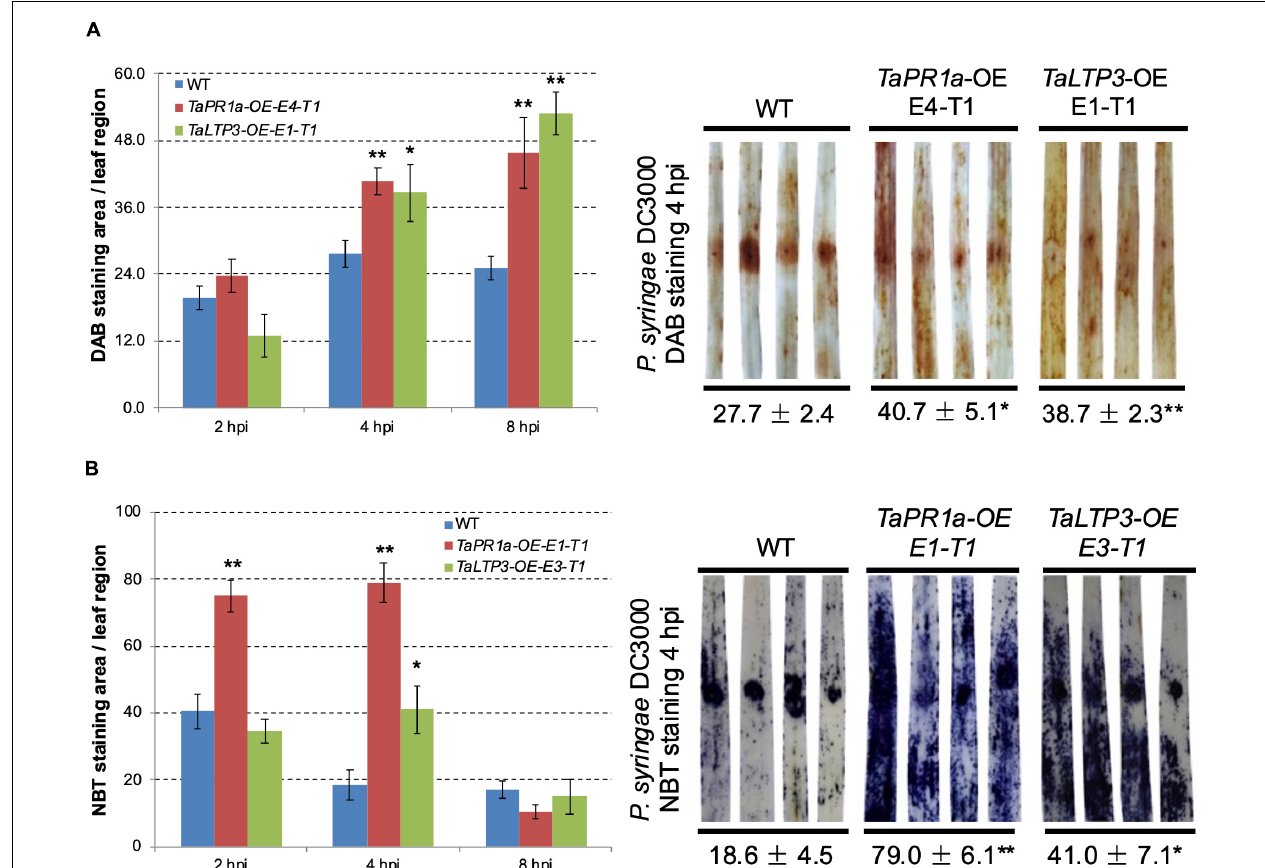
FIGURE 6 | Transgenic wheat lines TaPR1a-OE and TaLTP3-OE showed higher accumulation of reactive oxygen species (ROS) upon infection of model bacterial pathogen P. syringae DC3000. (A) Samples from the infiltrated region were collected at 2, 4, and 8 hours postinoculation (hpi) and further stained with 3,3-diaminobenzidine (DAB). (B) Corresponding samples were stained with nitroblue tetrazolium (NBT) to visualize the accumulation of superoxide anion (O 2 − ). The percentage of stained area in the infiltrated region was calculated By using the ASSESS software. Asterisk indicates the significance of the differences between the transgenic lines and wild-type plants established by using the Dunnett’s test (* p < 0.05, ** p < 0.01, Supplementary Tables 7 , 8